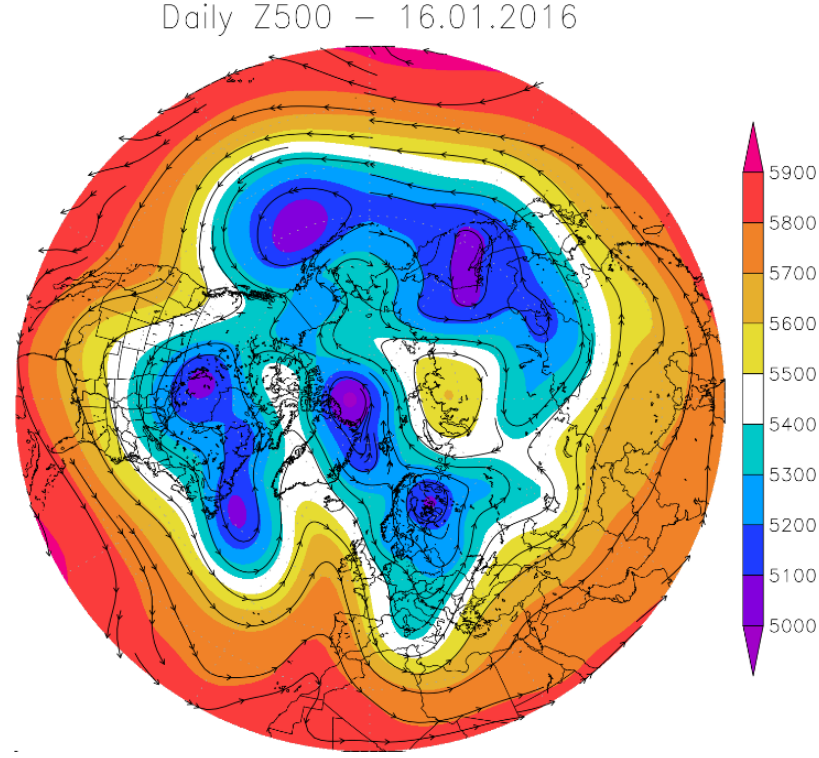
Figure 13. Daily geopotential height and wind at 500 mb on the 16th of January 2016.